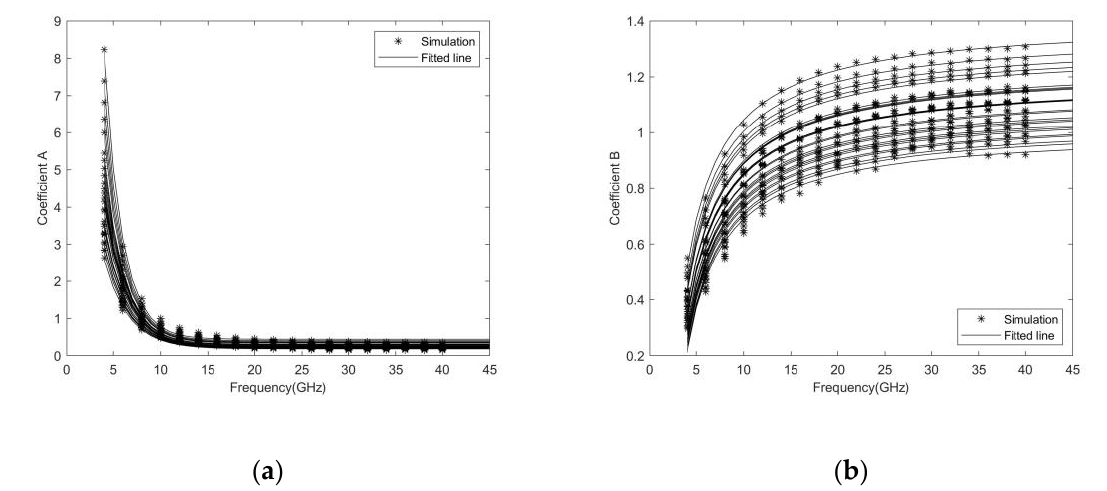
Figure 6. The fitted results of the relationship between coefficients A( a ) and B( b ) and frequency.